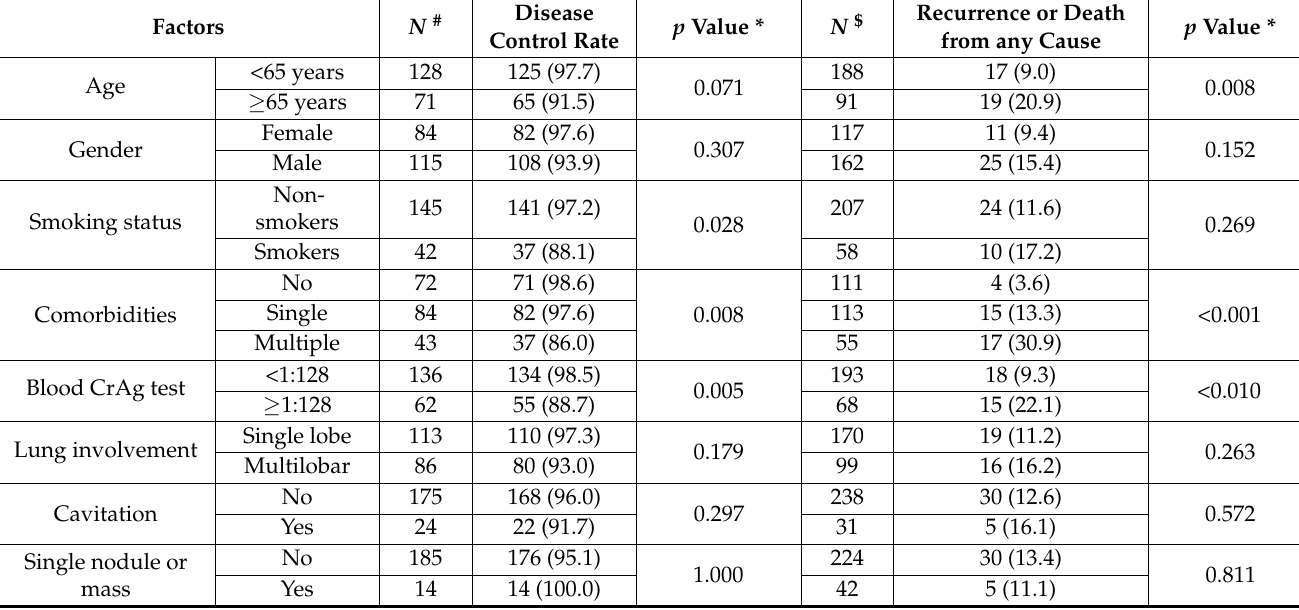
CrAg, cryptococcal antigen.* By Fisher’s exact test. # Analysis of disease control; excludes patients without treatment, with surgical resection, loss of follow-up, and not-cryptococcosis-related death before complete treatment. $ Analysis of recurrence of death; excludes patients with loss of